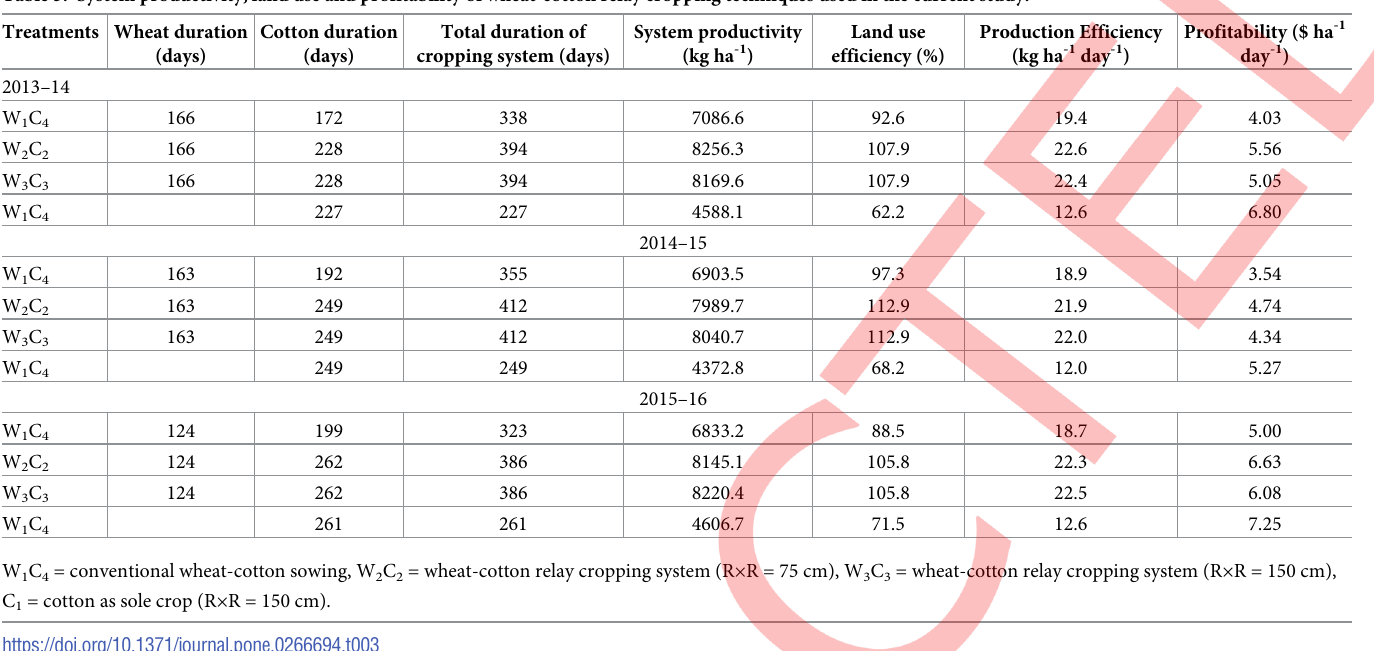
Table 3. System productivity, land use and profitability of wheat-cotton relay cropping techniques used in the current study. Treatments Wheat duration (days)